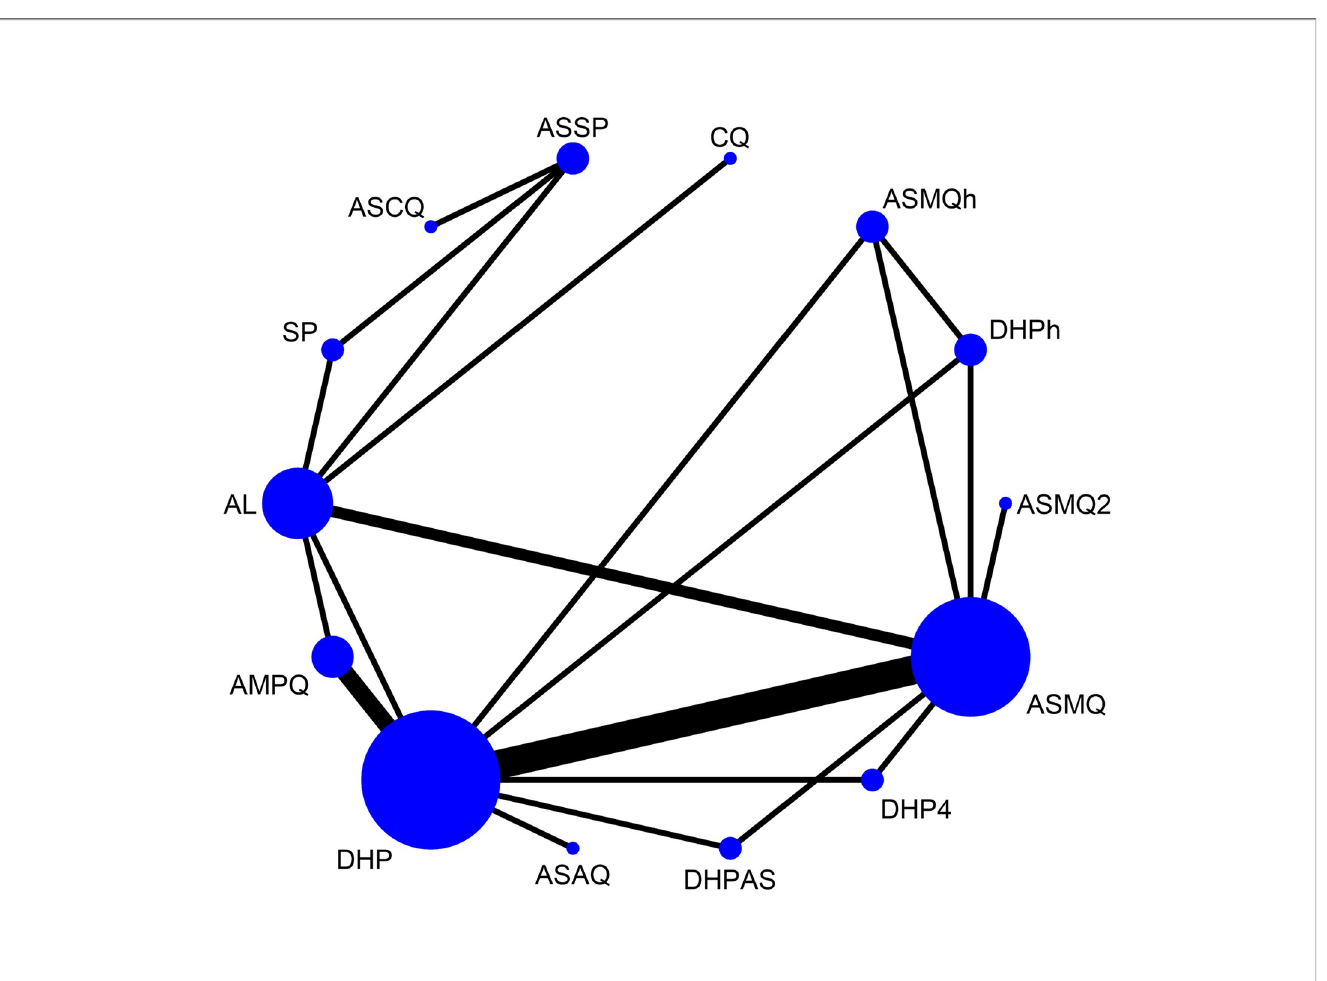
Fig 2. Network plot of the antimalarials for treating P . falciparum